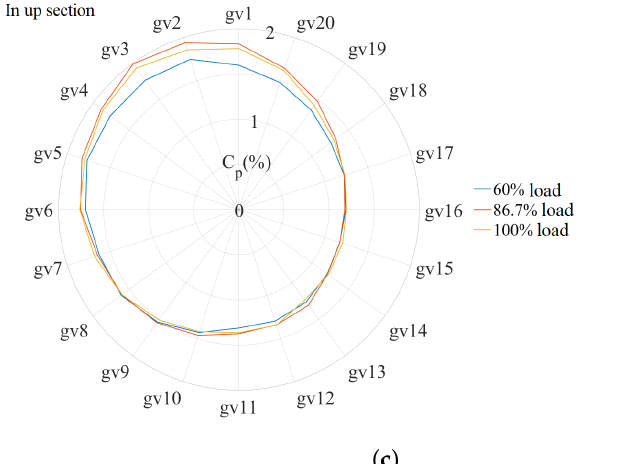
Figure 18. Polar diagram of the amplitudes of pressure fluctuations of the monitoring points along the circumferential direction. ( a ) f / f n = 7. ( b ) f / f n = 14. ( c ) f / f n = 21.